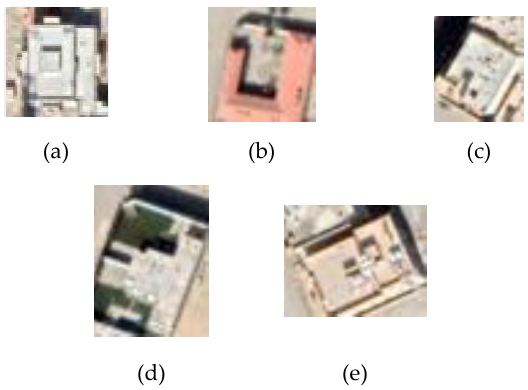
Figure 2. A sample of building images with different orientation angles from our collected dataset from Riyadh city ( a ) building image with orientation angle 0, ( b ) building image with orientation angle +10, ( c ) building image with orientation angle − 10, ( d ) building image with orientation angle − 20, and ( e ) building image with orientation angle